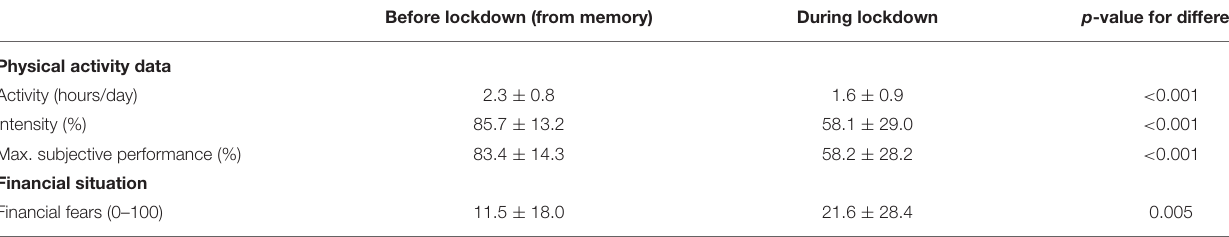
TABLE 2 | Data of bodybuilders and fitness athletes (BoFA) before lockdown ( N = 87). Before lockdown (from memory) During lockdown